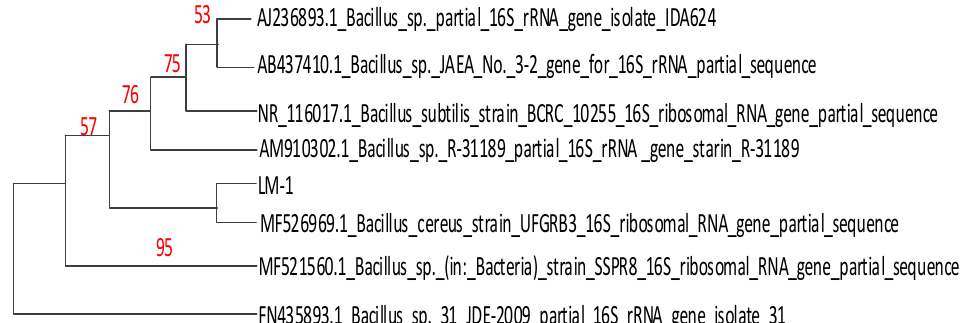
Figure 3. Results of PCR amplification of two bacterial isolates LM-1 and LM-2.